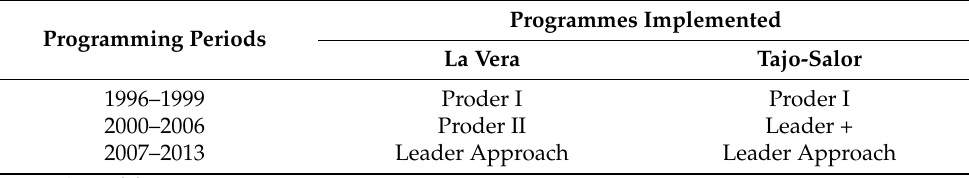
Table 1. Programming periods and programmes implemented in the study areas. Programming